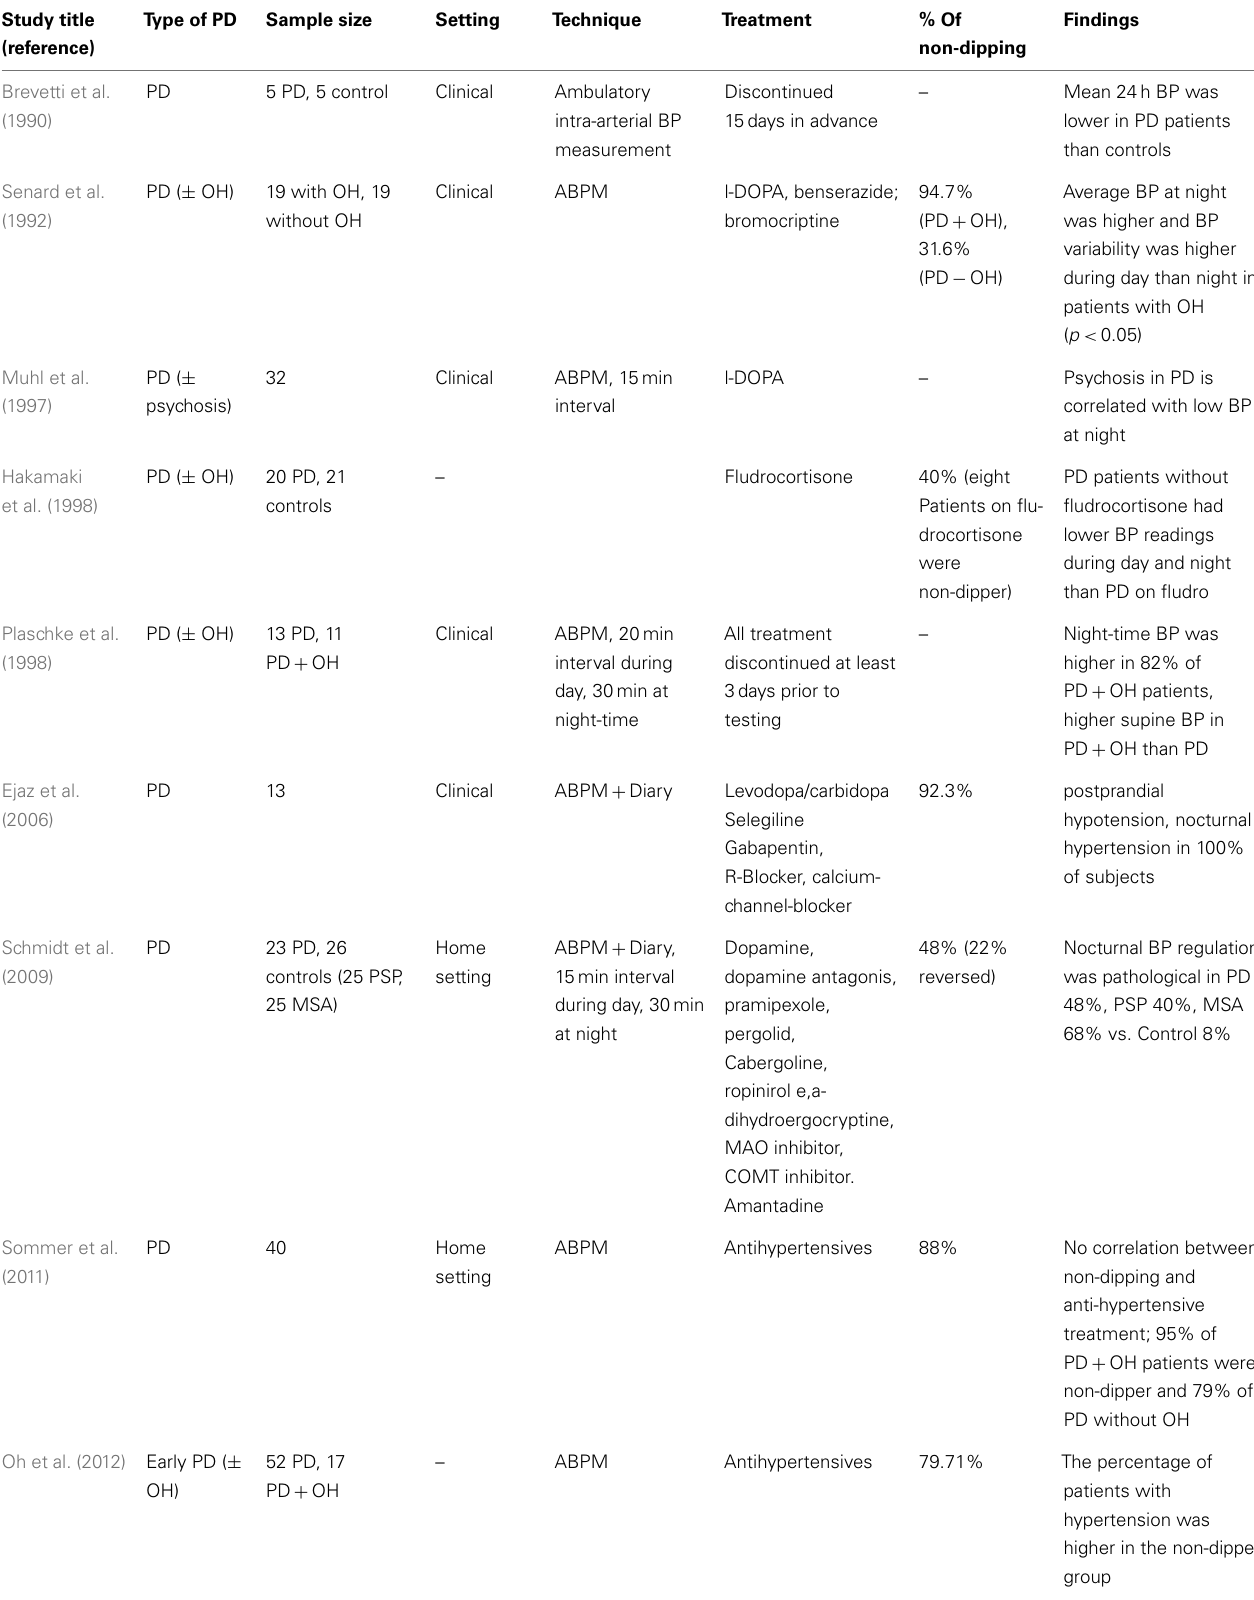
Table 2 |An overview of key findings 24 hrABPM studies in PD